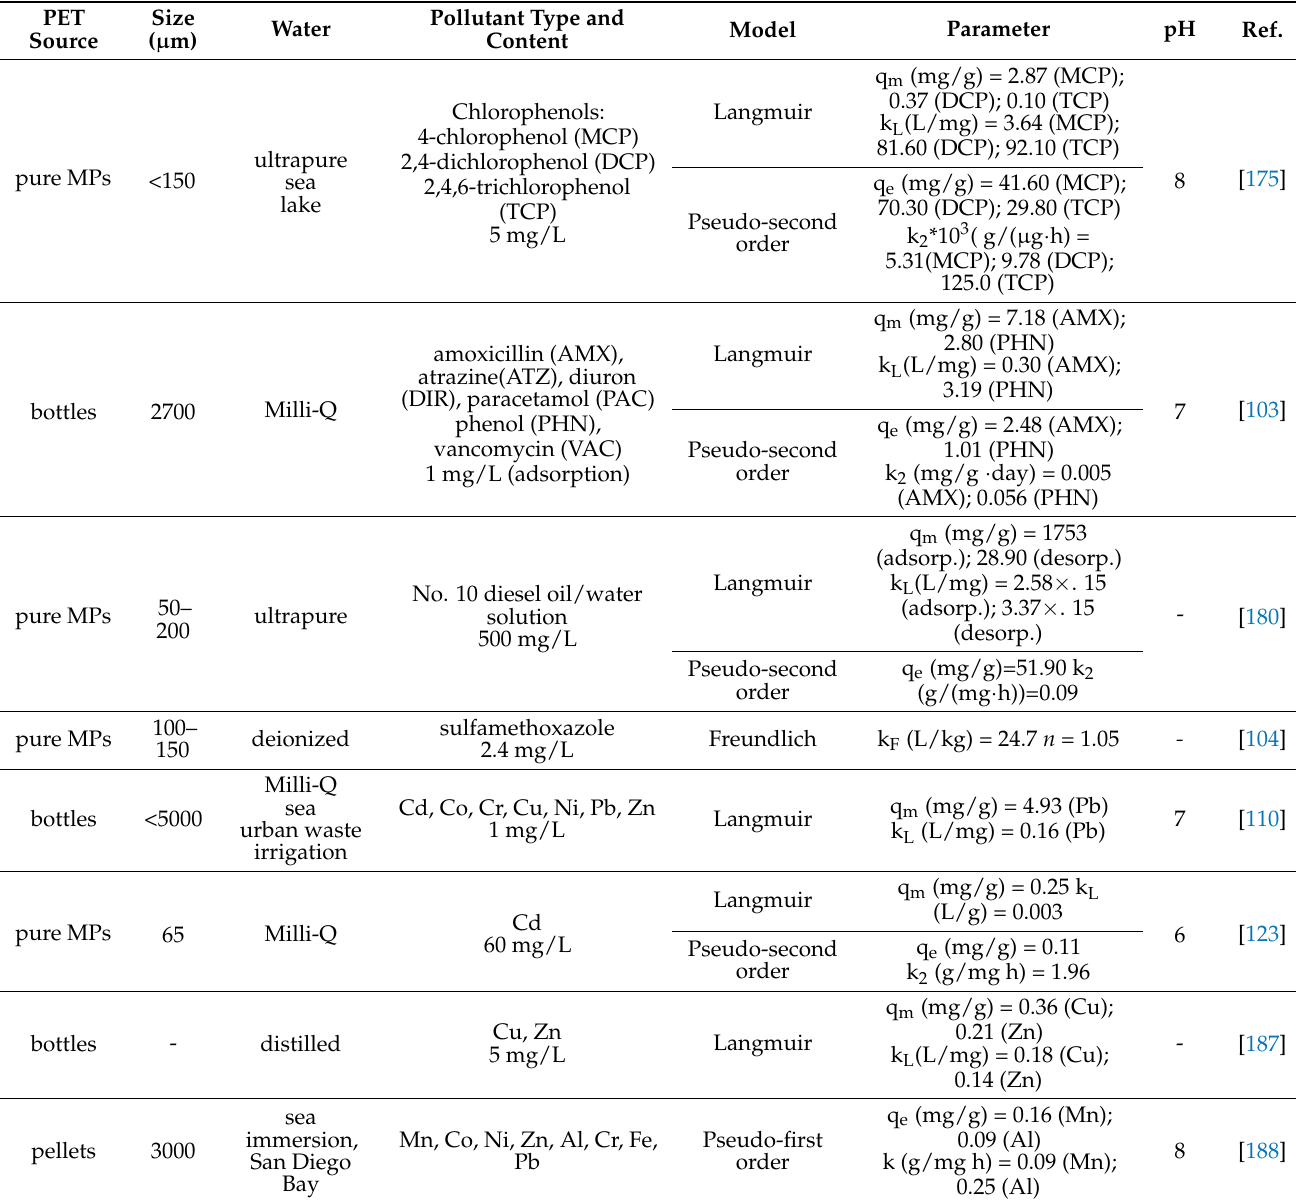
Table 3. Adsorption isotherm and kinetic studies on PET